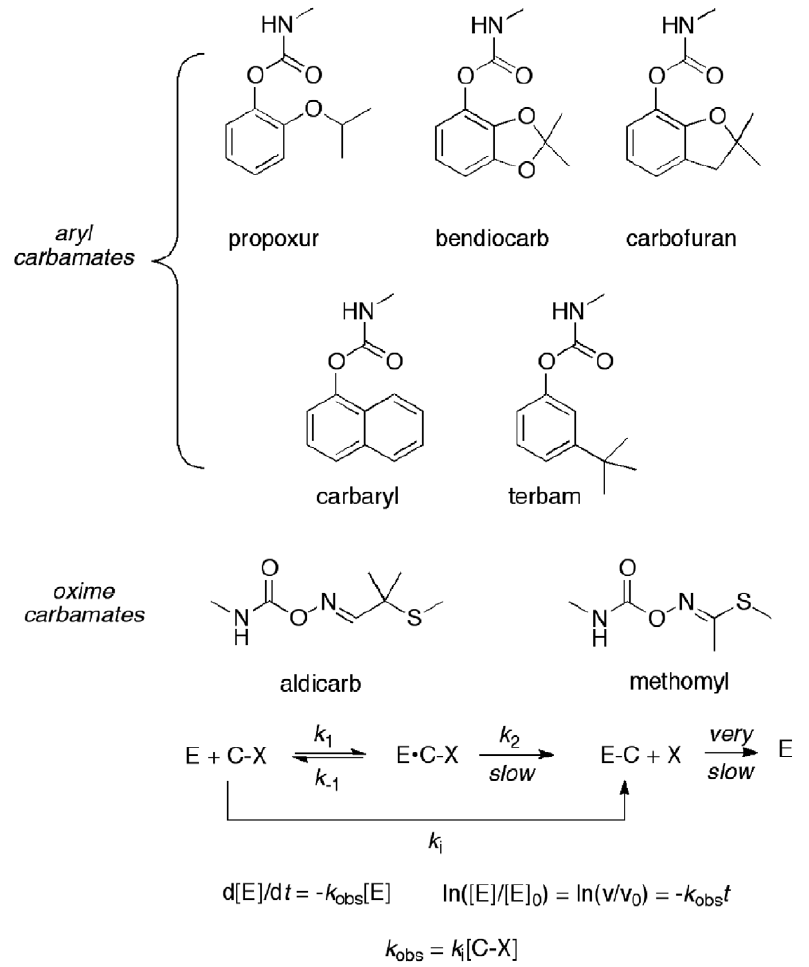
Figure 4. Structures of aryl and oxime carbamates studied, and scheme for carbamate (C–X) inhibition. Kinetic model describes determination of k obs by observing first-order loss of enzyme activity (v/v 0 ) at a fixed inhibitor concentration